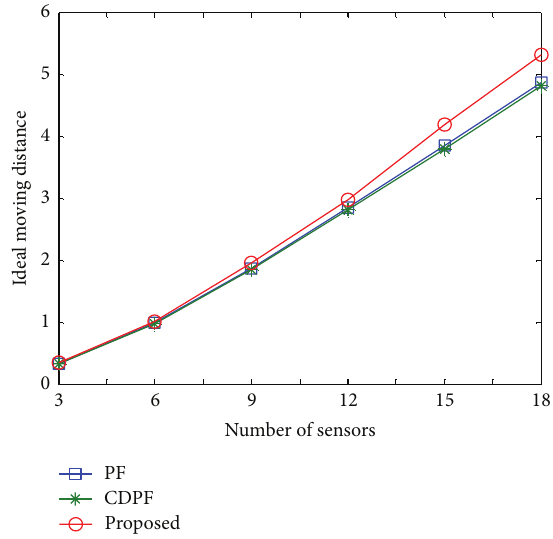
Figure 7: Coverage rate versus number of sensors.